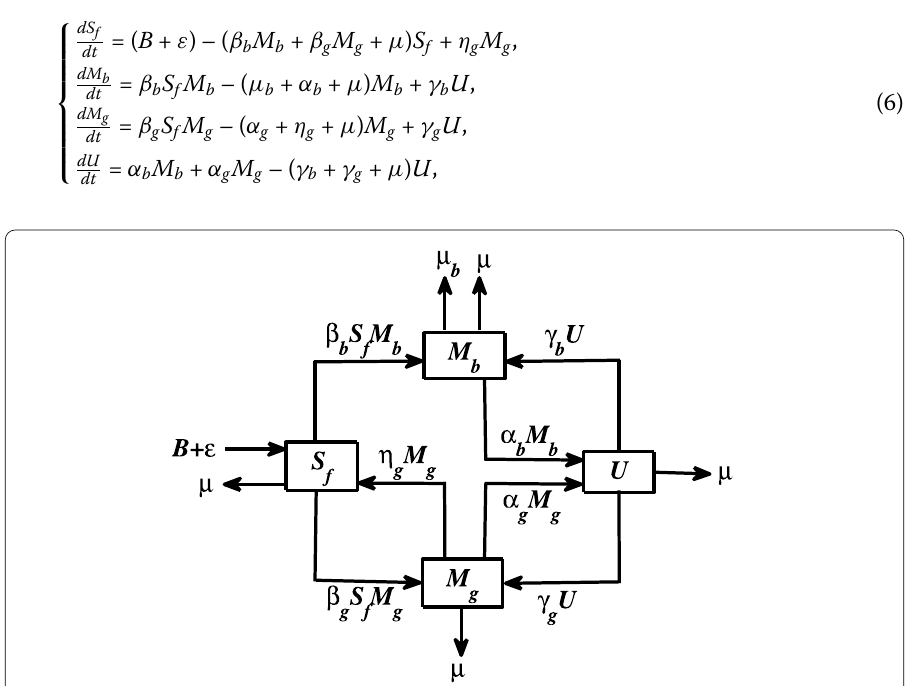
Figure 1 The transmission of malnutrition and